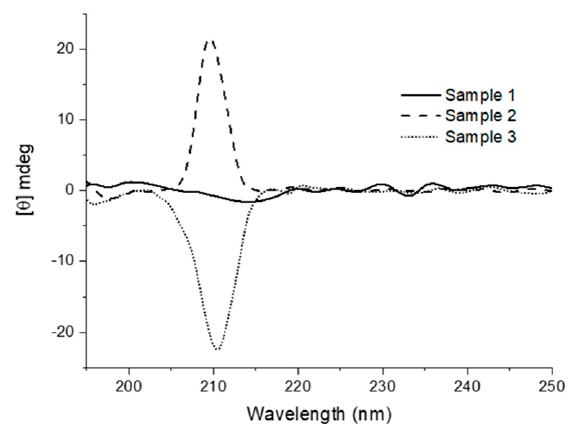
Figure 8. CD spectra of representative samples of xerogels of 12 (from toluene) in KBr at 25 °C. In all cases, the corresponding gels were prepared under sonication. The spectrum for each sample is the average of several measures. Reprinted with permission from Wiley [33].